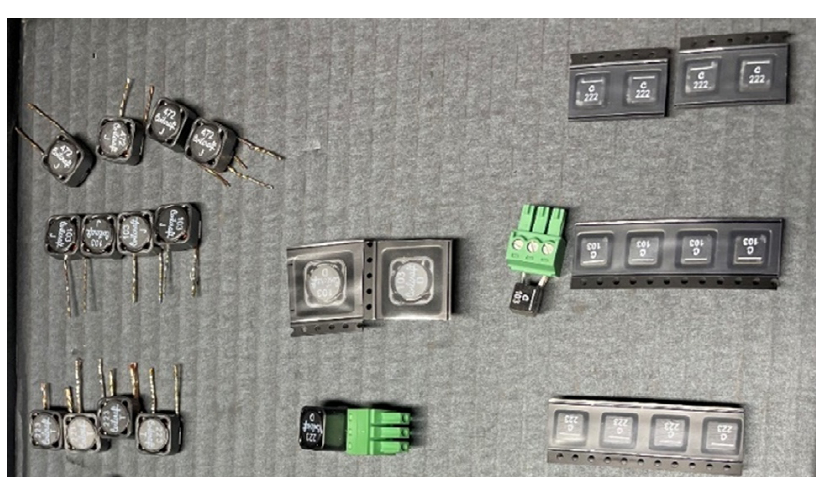
Figure 2. Picture of the 3 inductor series considered in this work [15–17]. Looking at plots Figure 3, one can see that, globally, the maximum stored energy (in